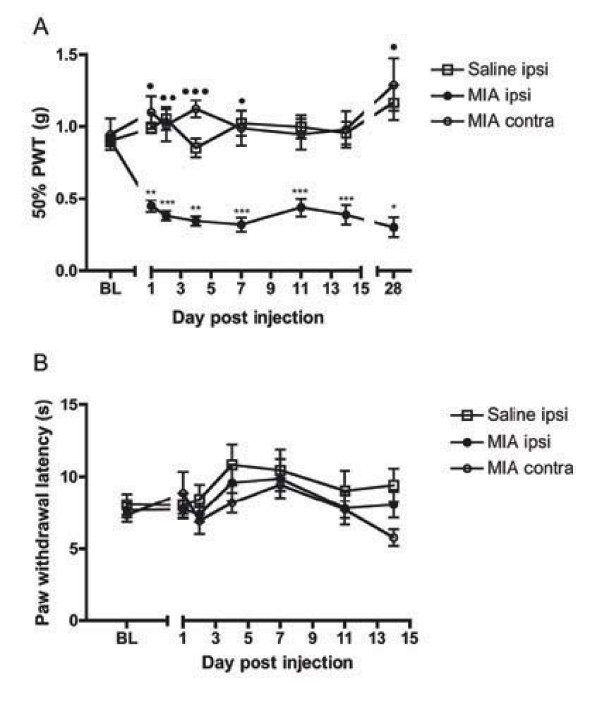
Behavioural nociception in MIA-injected mice. A. Development of mechanical hypersensitivity in MIA-injected mice. Graph depicts the changes in mechanical force required to elicit a paw withdrawal in response to a mechanical stimulus for the ipsilateral and contralateral hindpaws of MIA-injected mice (n = 18; day 28 n = 4) and the ipsilateral hindpaws of saline-injected mice (n = 16; day 28 n = 4). 50% paw withdrawal thresholds (PWT) are expressed as mean ± S.E.M. * denotes significant differences of ipsilateral MIA v ipsilateral saline; denotes significant differences of MIA ipsilateral v MIA contralateral. 3 symbols, p < 0.001; 2 symbols, p < 0.01; 1 symbol, p < 0.05. 2B. Lack of development of thermal hypersensitivity in MIA-injected mice. Graph depicts the time taken to elicit paw withdrawal in response to a noxious thermal stimulus for the ipsilateral and contralateral hindpaws of MIA-injected mice (n = 11) and the ipsilateral hindpaws of saline-injected mice (n = 11).